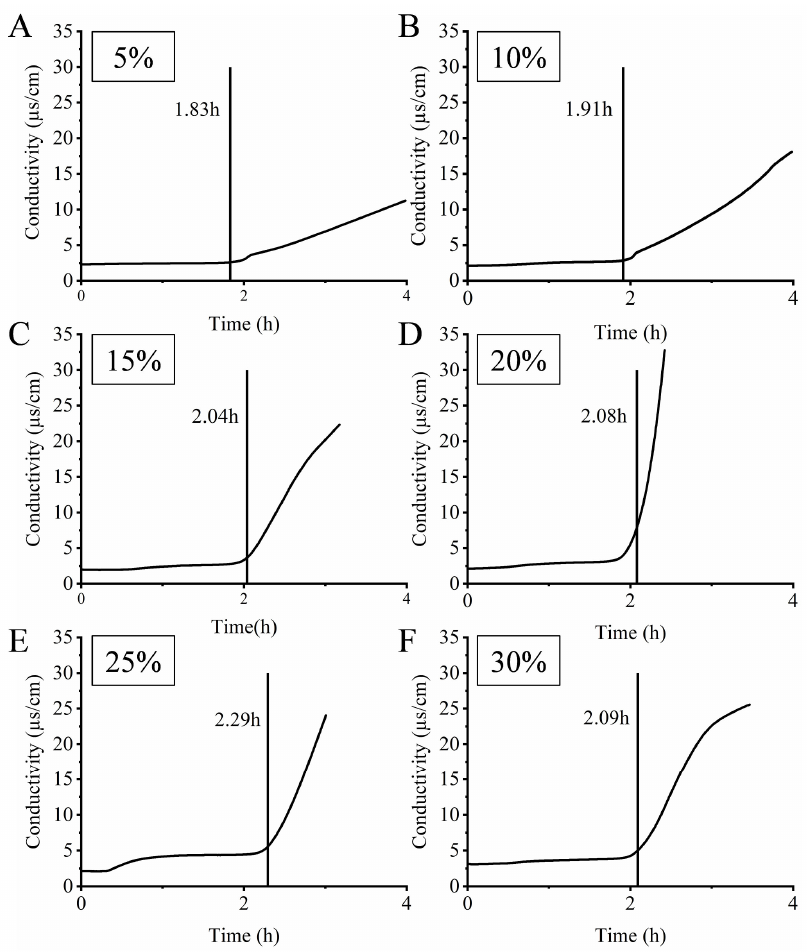
Figure 7. Oxidation induction time of HIPEs ( A – F ) with different levels of Antarctic krill oil (AKO) (5, 10, 15, 20, 25, and 30%, w/w ) subjected to accelerated oxidation at 120 °C under a 20 L/h air flow.